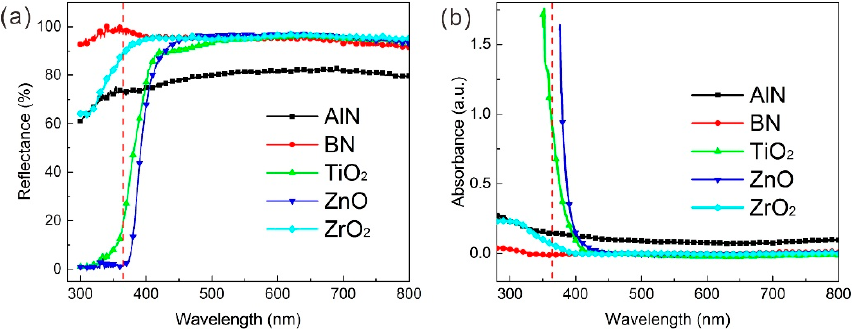
Figure 1. ( a ) The reflectance and ( b ) absorbance of AlN, BN, TiO 2 , ZnO, and ZrO 2 nanoparticles (NPs); the dotted red line indicates 365 nm.